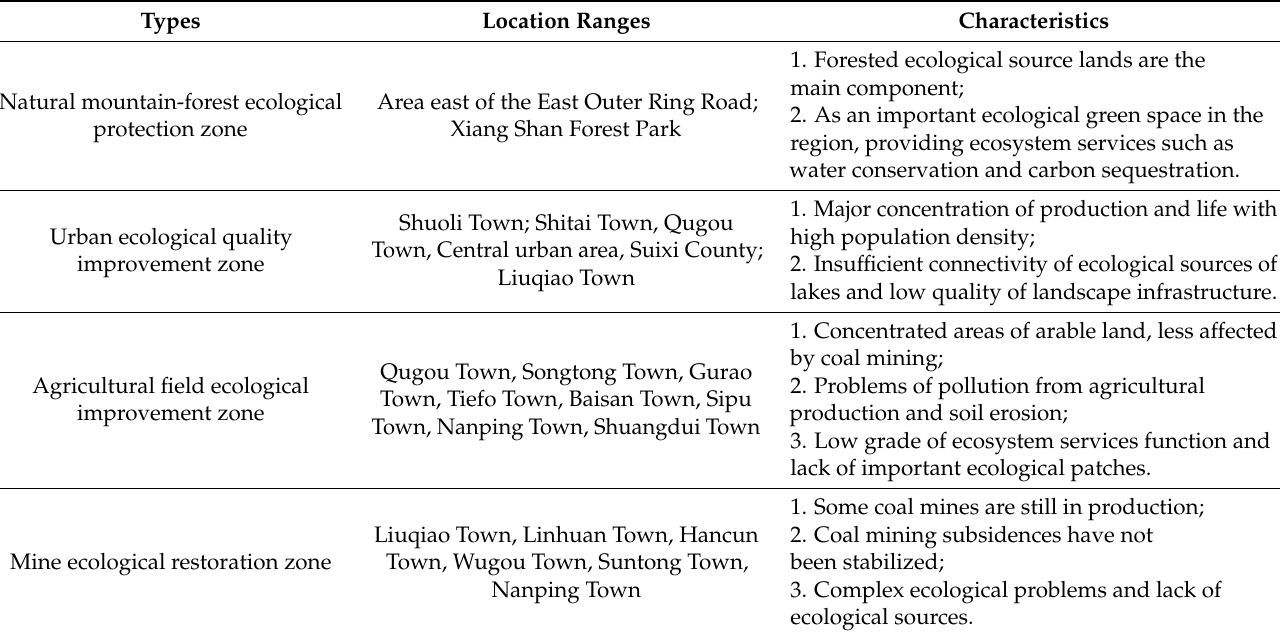
Figure 14. Ecological restoration and protection pattern in Huaibei City. Table 7. Ecological restoration and protection type